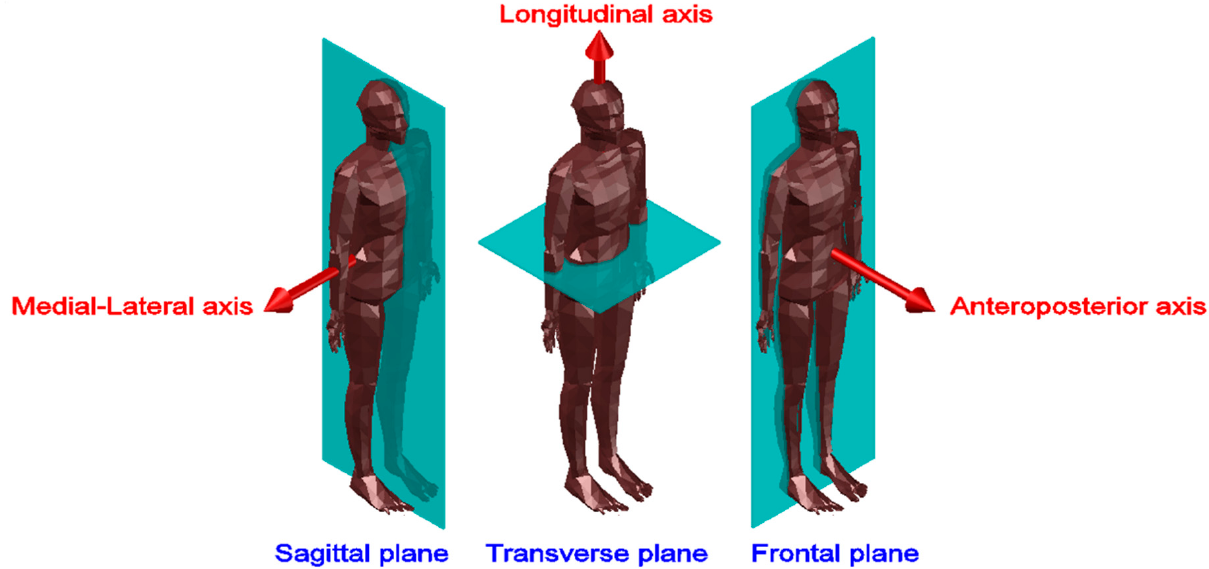
Figure 1. Planes and axes of movement of the human body.